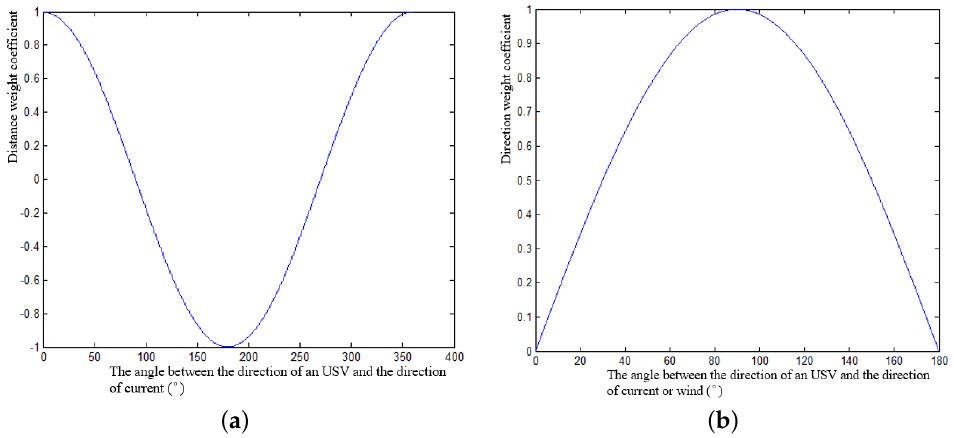
Figure 9. Wind and current impacts on the weight of motion planning. ( a ) Current impacts on the weight of motion planning. ( b ) Wind and current impacts on the planned heading of motion.